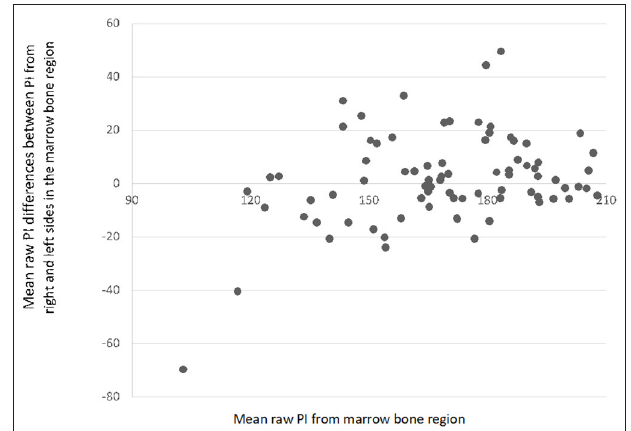
FIGURE 5 | Scatterplot with mean differences between pixel intensity (PI) values from the right and left sides in the medullary region ( N =